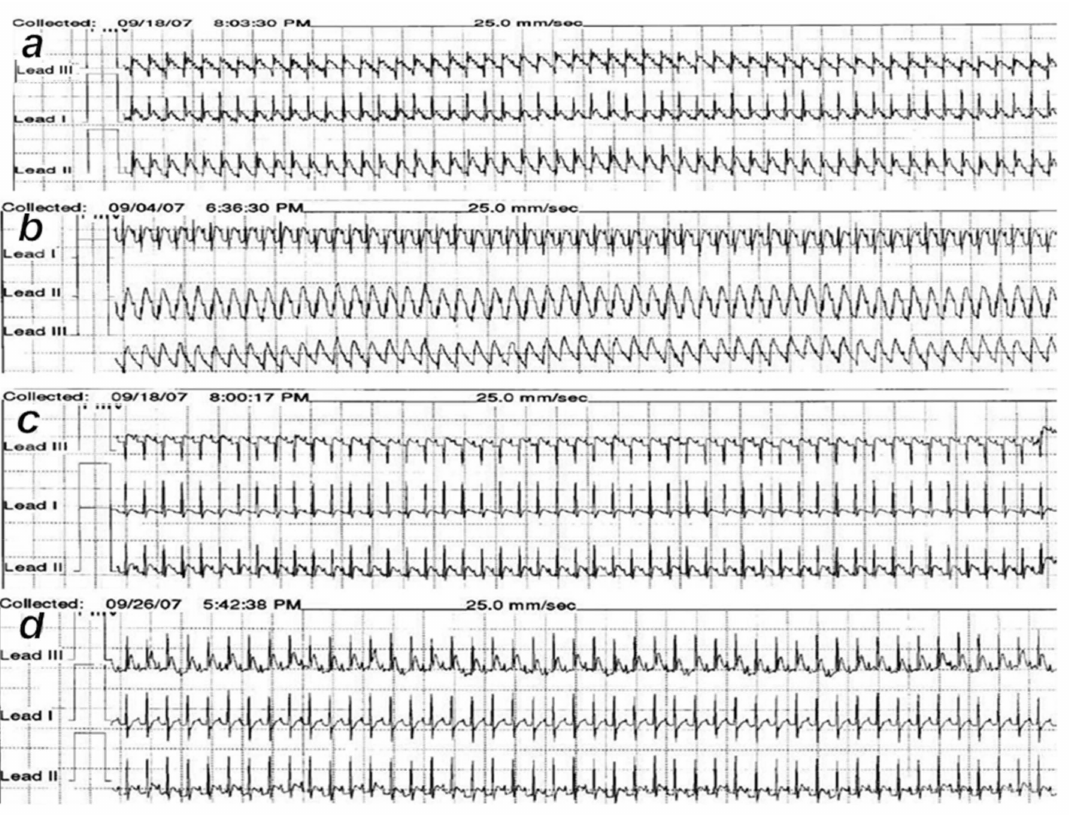
Figure 17. ECG presentation. Rats challenged once with isoprenaline 150 mg/kg s.c., medication at 30 min before isoprenaline. ( a ) ST elevation in all 3 standard leads in controls that received saline (5 mL/kg ip) 24 h after first isoprenaline challenge. ( b ) L-NAME (5 mg/kg i.p.) medication at 30 min before isoprenaline presented with ST elevation in all 3 standard leads. ( c ) L-arginine (200 mg/kg i.p.) presented with less expressed ischemic ECG changes at 24 h after initial isoprenaline dose. ( d ) BPC 157 (10 µ g/kg i.p.) presented with no ST-T ischemic